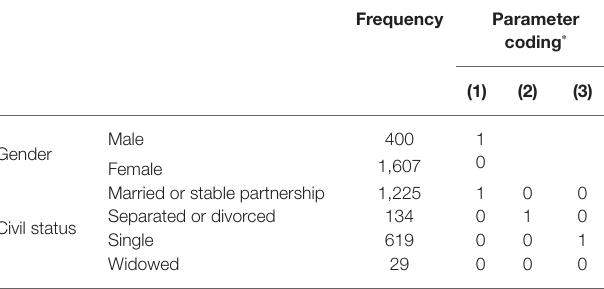
TABLE 1 | Frequencies and parameter coding (1) for the sociodemographic variables included in the regression